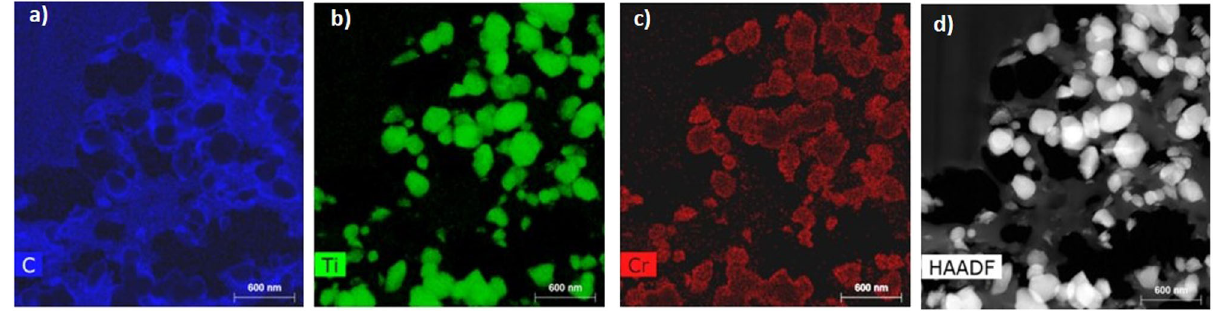
Fig. 7 STEM/EDS analysis of 50TiO 2 fi lm after 14 days of exposure to aqueous Na 2 CrO 4 solution at 60 °C. a – c Distribution of C, Ti, Cr in the selected region of